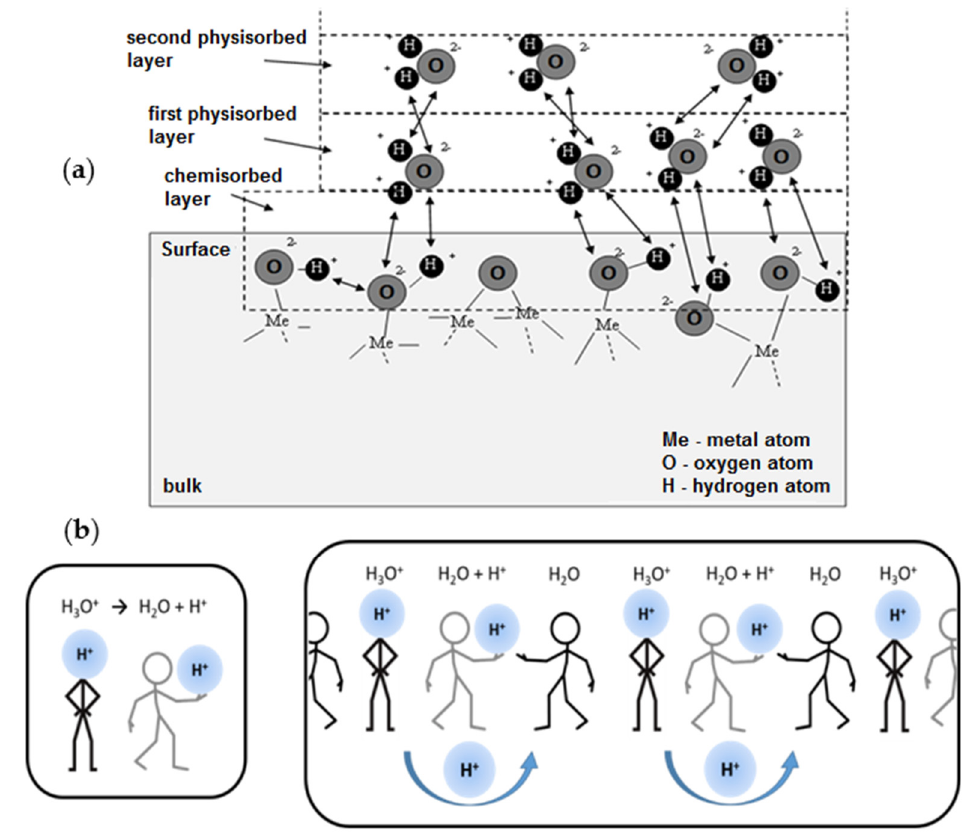
Figure 6. ( a ) Scheme of the chemisorbed and physiosorbed water layers on the oxides surface and ( b ) illustrative representation of the Grotthuss